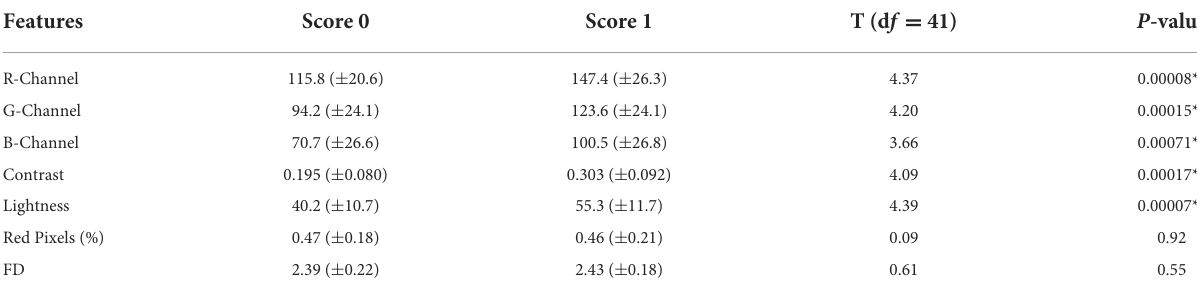
TABLE 2 Results of the group comparison of features between self-portraits scored 0 for pain and anger and those scored 1. Features